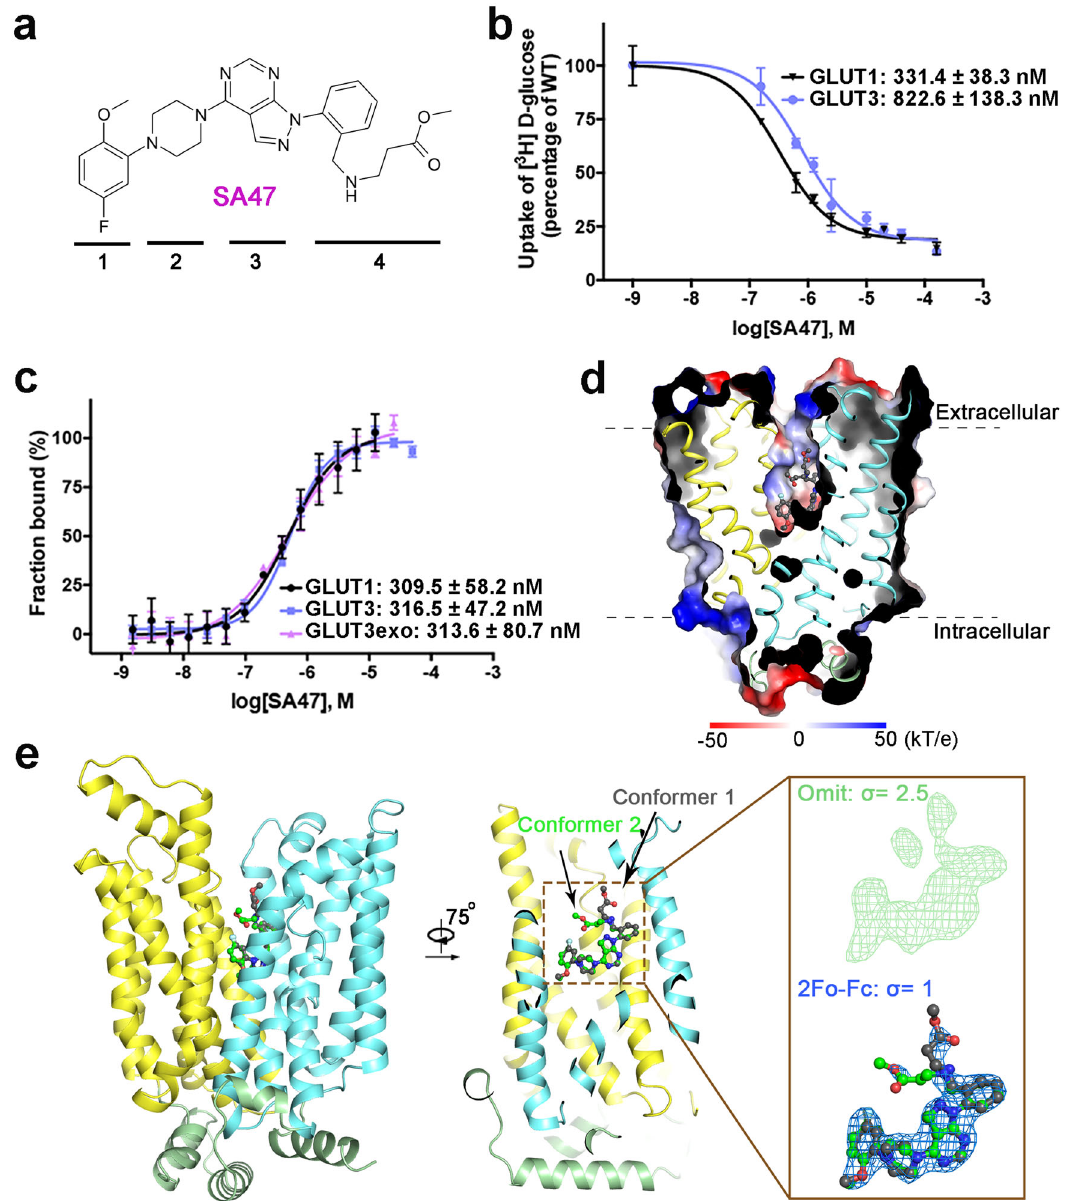
Fig. 2 SA47 is an exofacial GLUT inhibitor. a Chemical structure of SA47. The four moieties of SA47 are indicated by the numbers below the structure. b Inhibition of GLUT1 and GLUT3 by SA47. Data represents mean ± SD of three independent experiments. c SA47 has similar af fi nity with GLUT1, GLUT3, and GLUT3exo. Data represent mean ± SEM of three independent MST measurements. d Crystal structure of SA47-bound GLUT3 (GLUT3-SA47) in an outward-facing state. Shown here is the cut-open side view of the electrostatic surface potential of GLUT3-SA47. e Binding pose of SA47. Inset : Electron density of SA47. The omit map and 2Fo-Fc maps are shown as green and blue meshes, contoured at 2.5 σ and 1 σ , respectively. Two conformers of SA47, shown as ball and sticks, are colored dark gray and green. Source data are provided as a Source Data fi